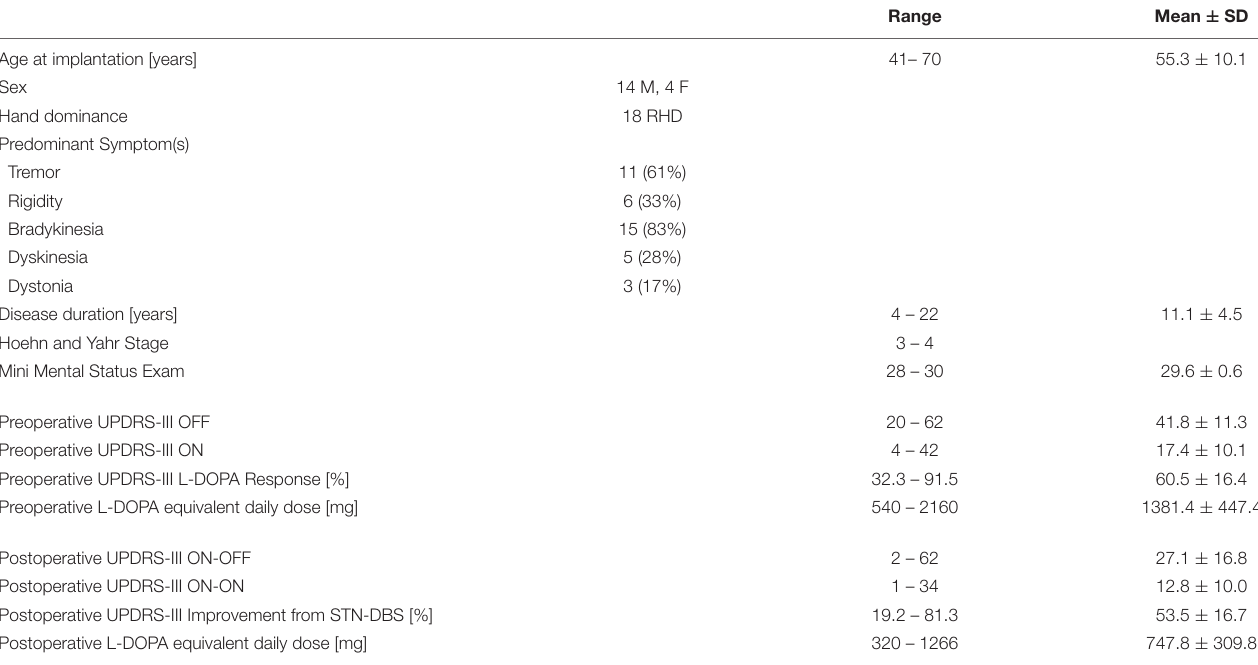
TABLE 1 | Patient information and response to